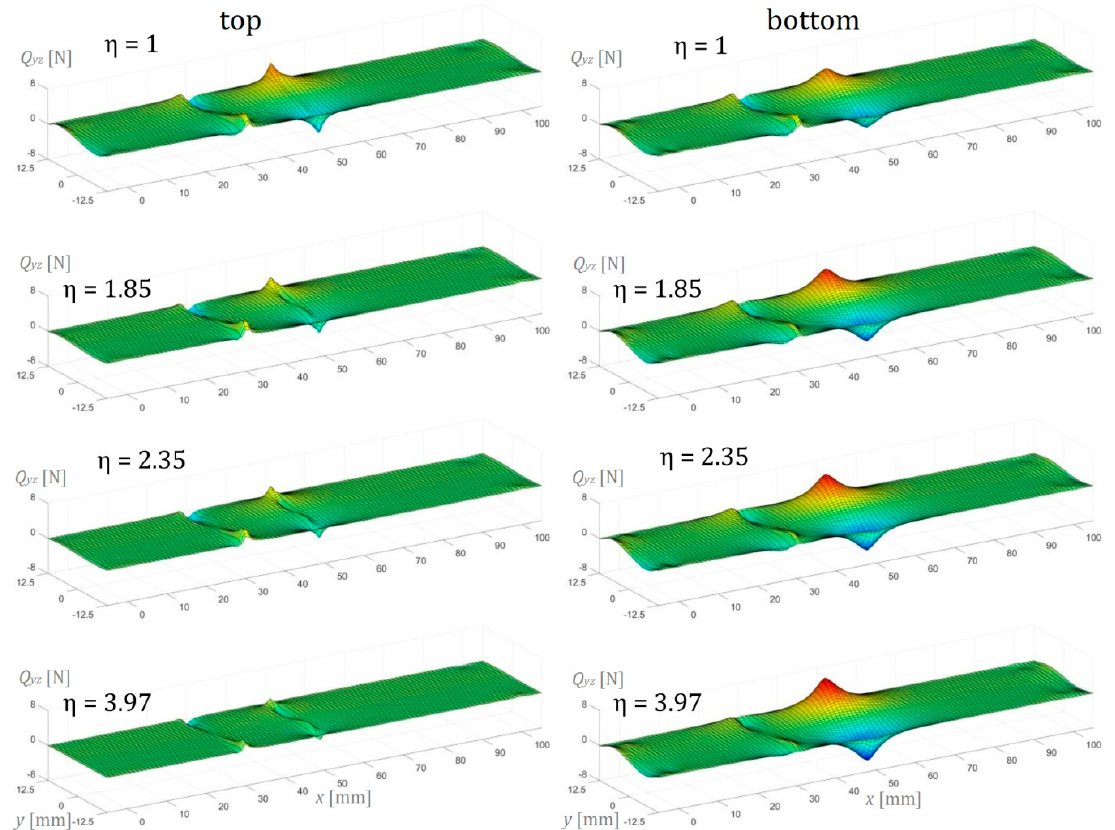
Figure 17. Transverse shear force per unit width Q yz in the perpendicular direction of the AENF.